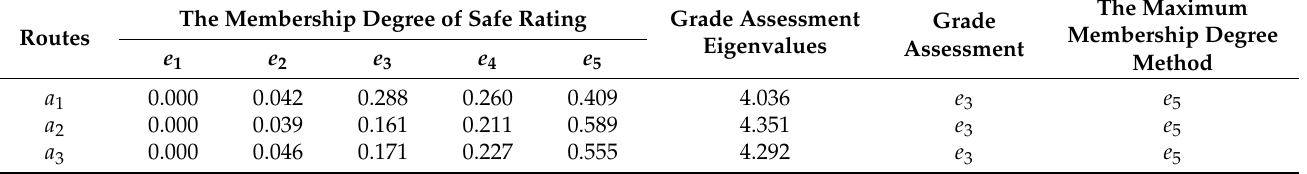
Table 3. Results for grade assessment of waterway navigation safe routes ( λ = 0.5 )